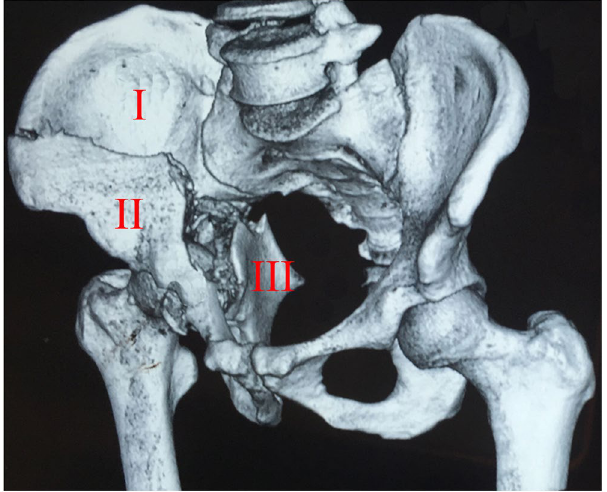
Figure 1. The hemipelvis was divided into three main fragments. Fixed posterior iliac fragment (I), anteromedially displaced iliopubic fragment (II), medially displaced ischial fragment (III).